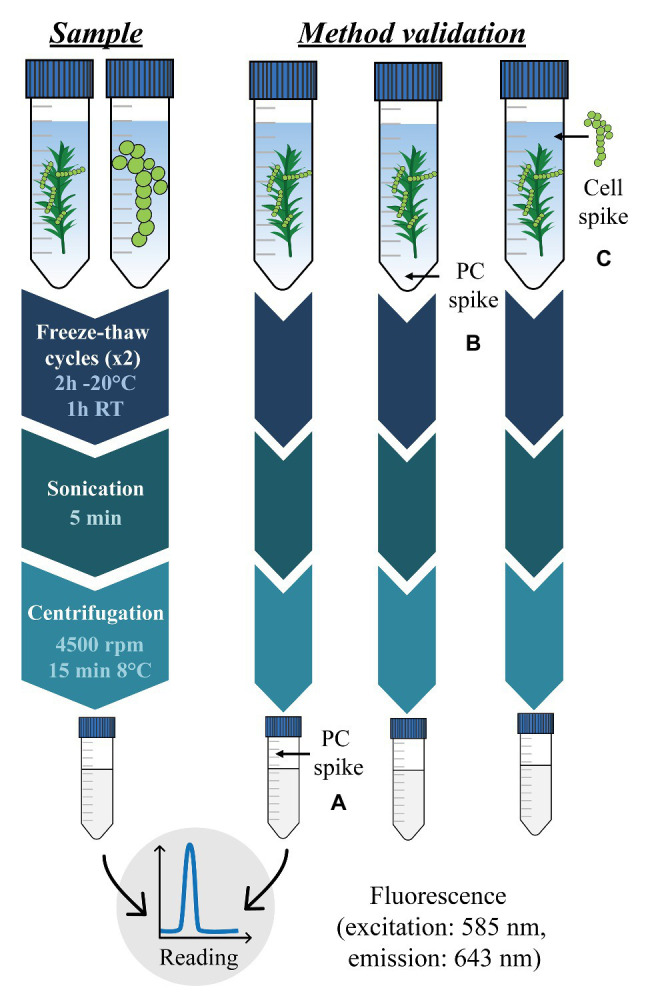
Phycocyanin (PC) extraction and quantification procedure for cyanobacteria in cultures and moss samples (left) and method validation process (right). Capital letters in brackets refer to three analytical performance parameters evaluated for the method validation. (A) corresponds to matrix effects, (B) corresponds to standard phycocyanin apparent recovery, and (C) corresponds to cellular phycocyanin apparent recovery.